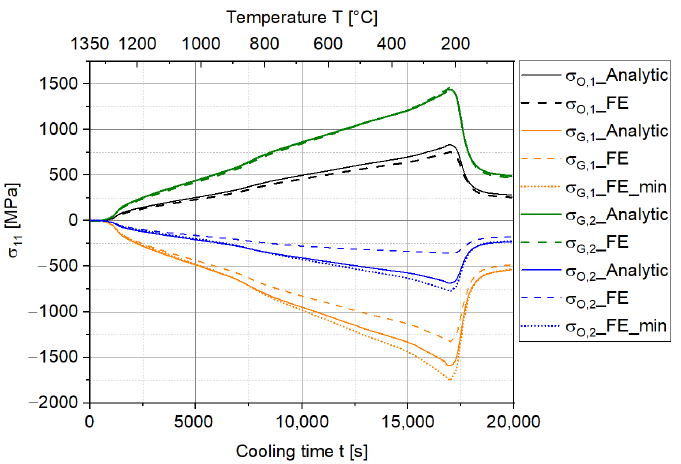
Figure 11. Comparison of the stress distributions of the two-layer MCLs between the analytic solution and FE simulation after consideration of the CTE during the cooling down process.